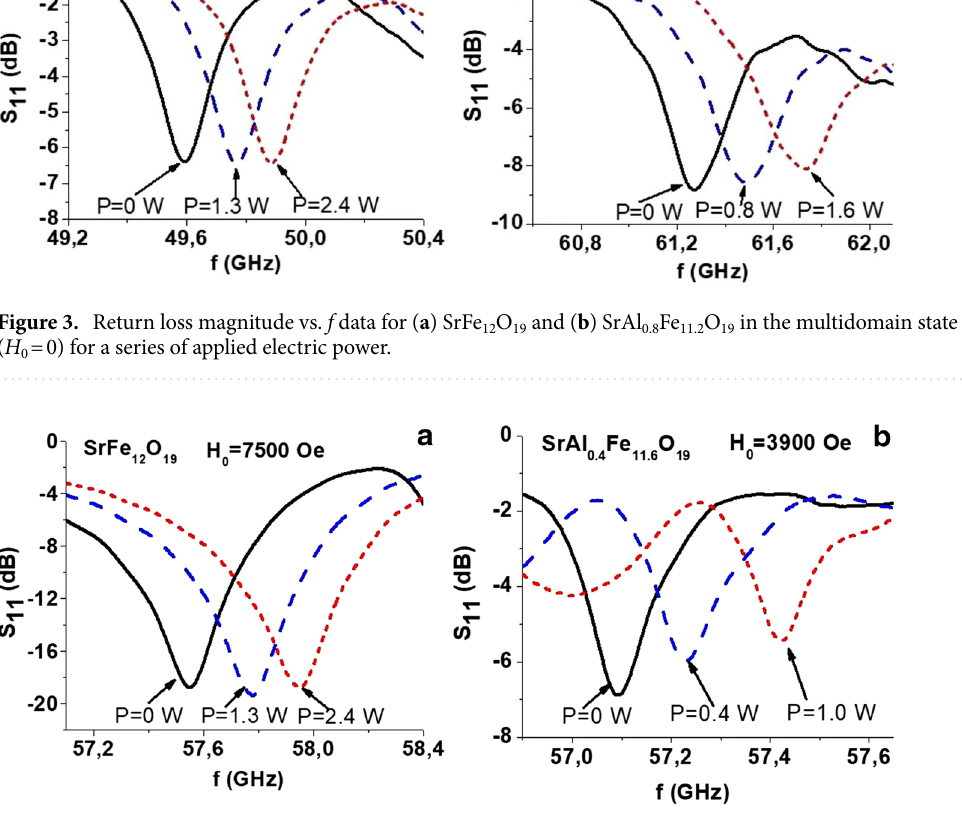
Figure 4. Data as in Fig. 3 for resonance absorption in the single domain state of ( a ) SrFe 12 O 19 and ( b ) SrAl